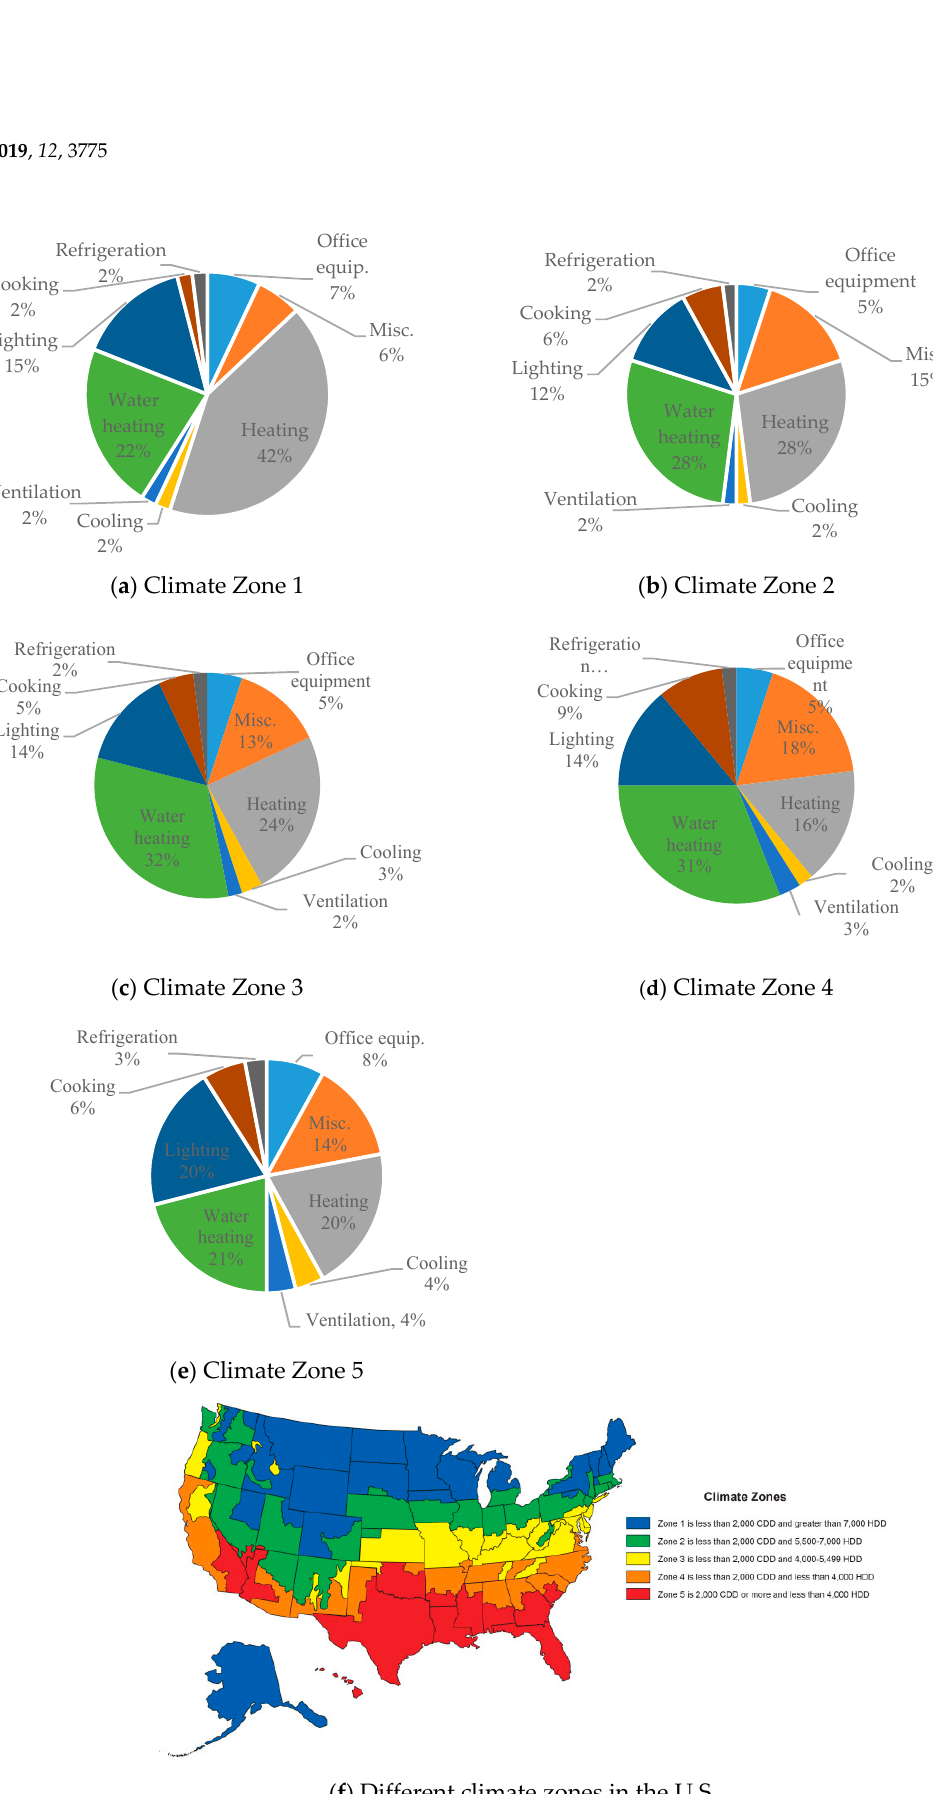
Figure 4. Hospitals’ annual energy consumption for the five climate zones in the U.S. ( a ) Climate Zone 1; ( b ) climate Zone 2; ( c ) climate Zone 3; ( d ) climate Zone 4; ( e ) climate Zone 5; ( f ) climate zones marked on the U.S. map.